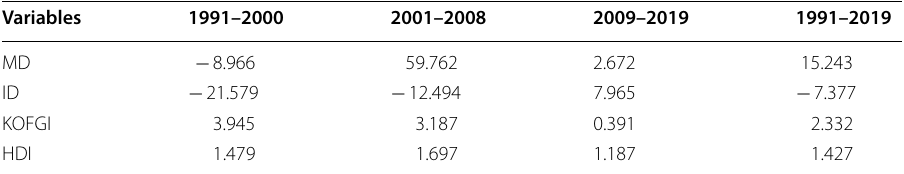
Table 1 Average annual growth rate (AAGR) of the variables